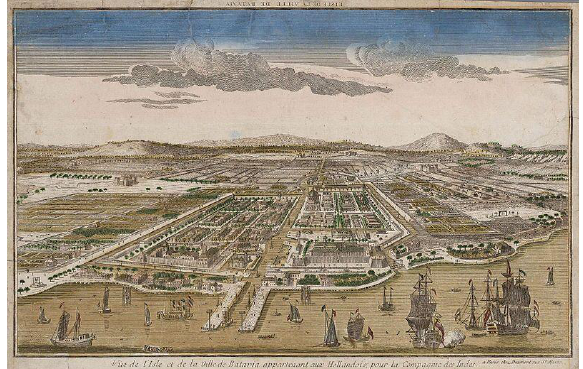
Figure 8. View of the island and the city of Batavia, underscoring Dutch planning doctrine. Daumont, Paris c. 1780. NL. Universiteit Bibliotheek.